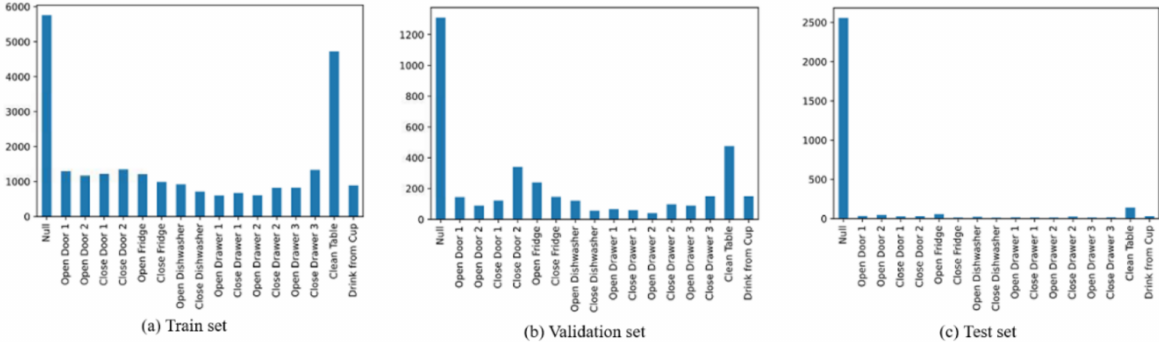
Figure 10. ( a ) Training set distribution after resampling, ( b ) validation set distribution after resampling, ( c ) test set distribution after resampling.